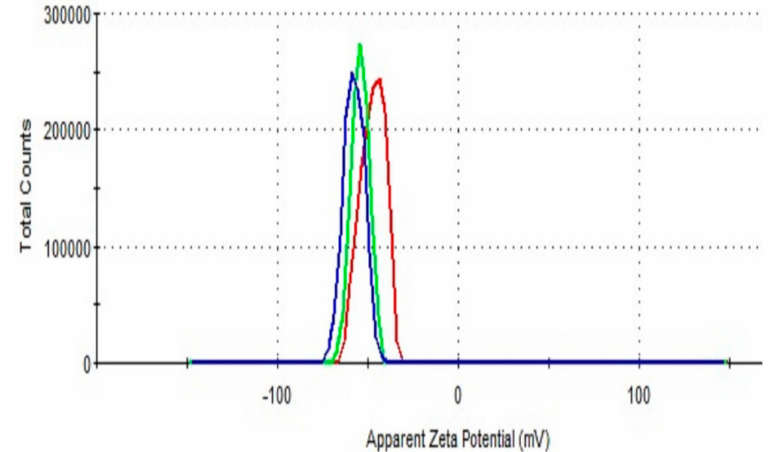
Figure 5. Zeta potential distribution of the Ag-NPs at a reaction time of 48